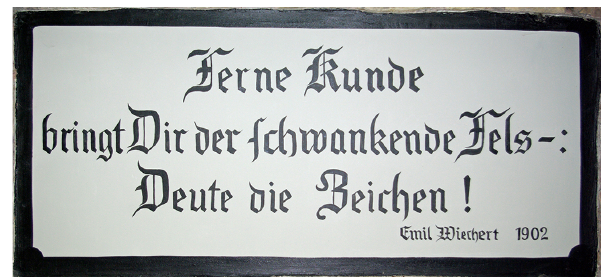
Figure 4. The inscription by Emil Wiechert: The trembling rock bears tidings from afar –: Read the signs! Photo: Udo Wedeken.